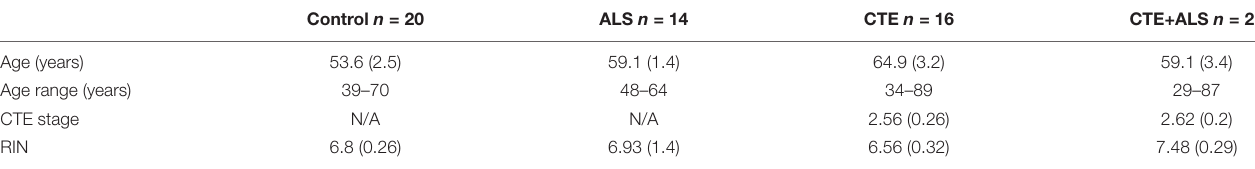
TABLE 1 | Variation in pathological group demographics.